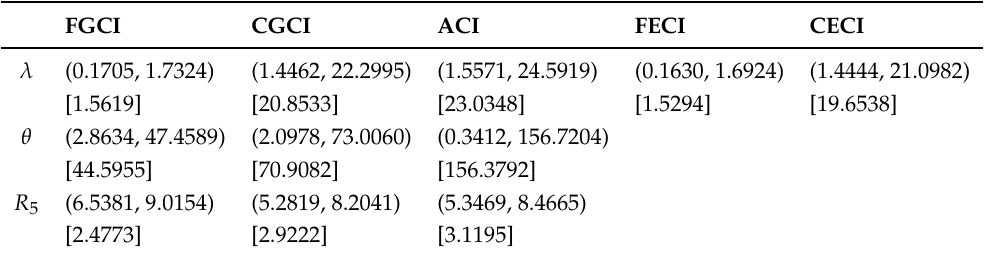
Table 3. Interval and prediction interval estimates of parameters using breakdown record data (7) of the electrical insulating fluid.